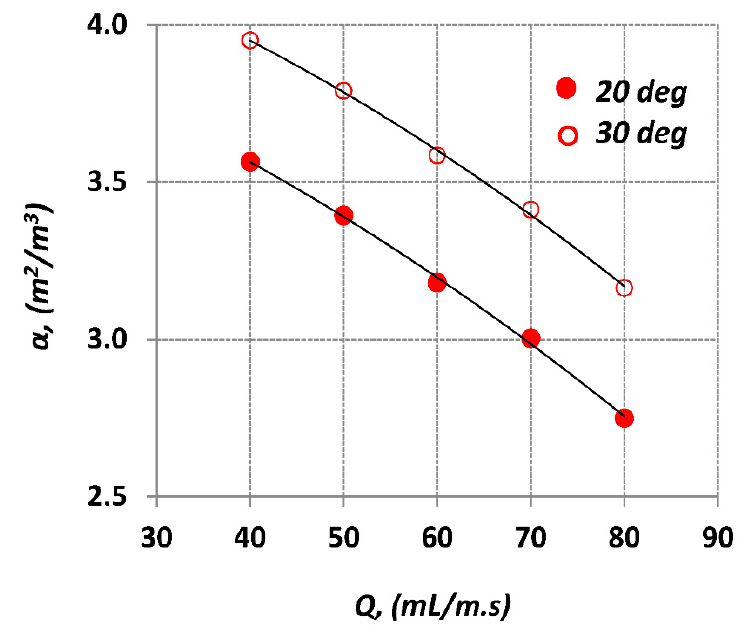
Fluids 2019 , 4 , x FOR PEER REVIEW Figure 13. Effect of liquid flow rate and inclination on the specific surface, for nW .